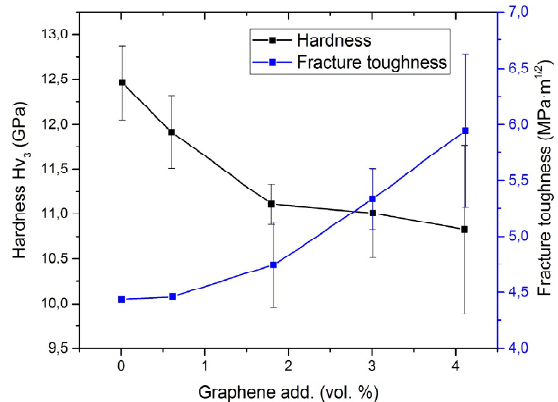
Fig. 5. Vickers hardness and crack resistivity of 3YSZ ceramics produced by SPS approach vs rGrO contents, data reported in [78].